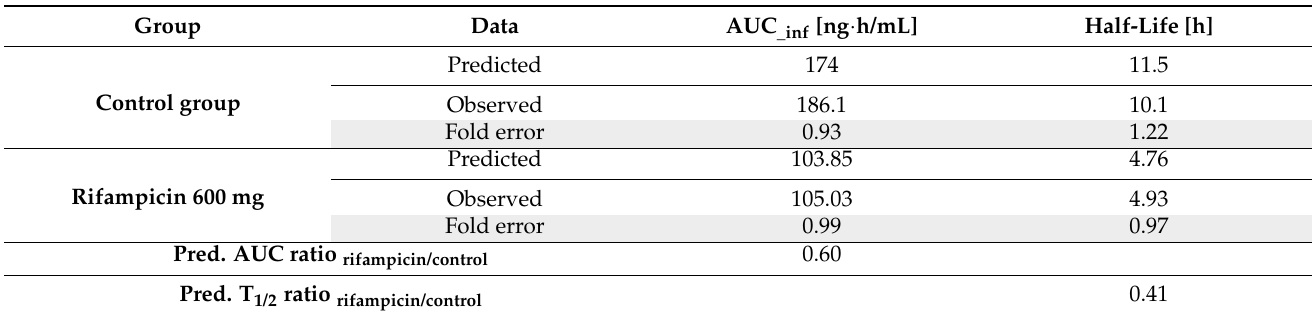
Table 6. Comparison of PK parameters for haloperidol in the presence and absence of the CYP3A4 inducer rifampicin.